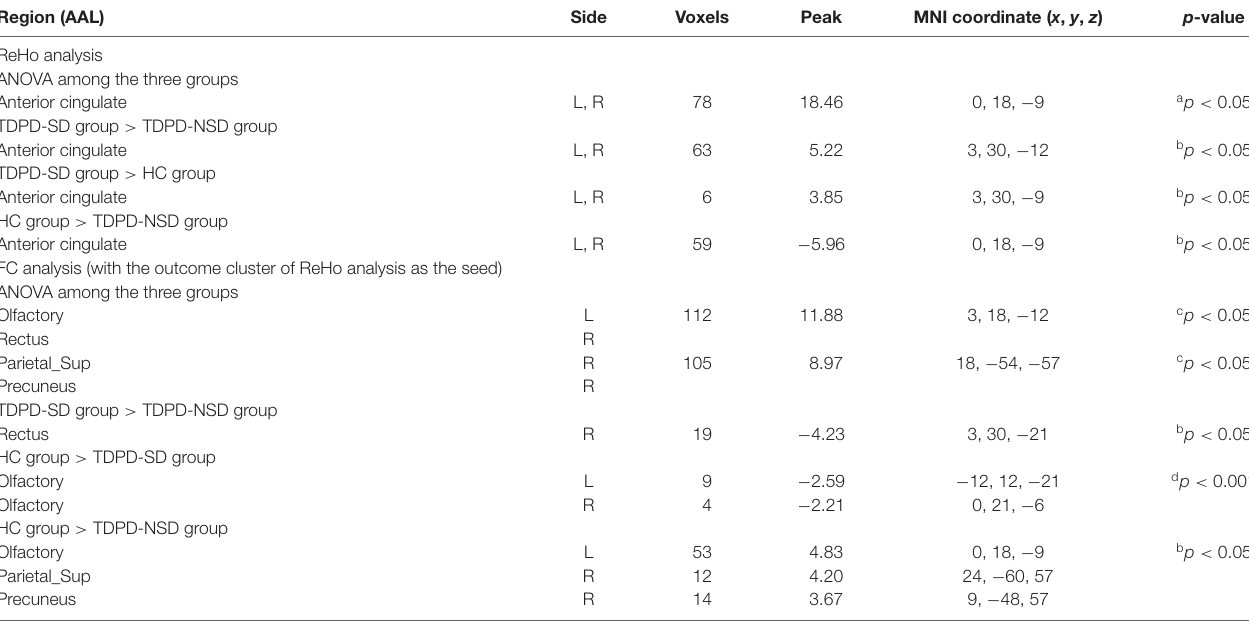
TABLE 2 | Brain areas with ReHo and FC differences among all groups. Region (AAL) Side Voxels Peak MNI coordinate ( x , y , z